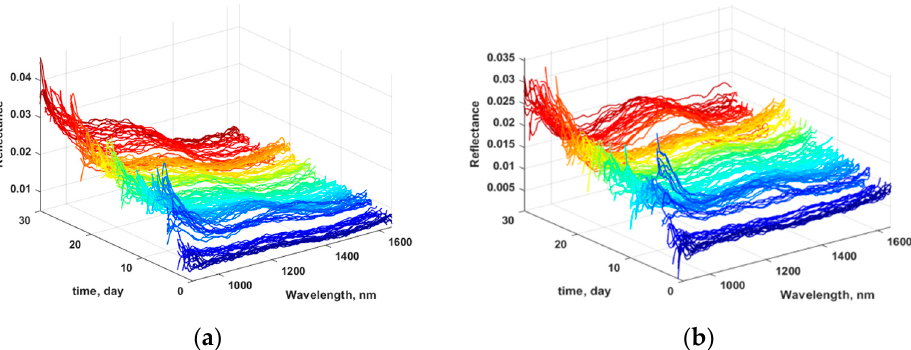
Figure 4. Development of the reflectance spectra of sample S6: ( a ) foil side excitation, ( b ) electrode side excitation. One color groups data measured during one day.